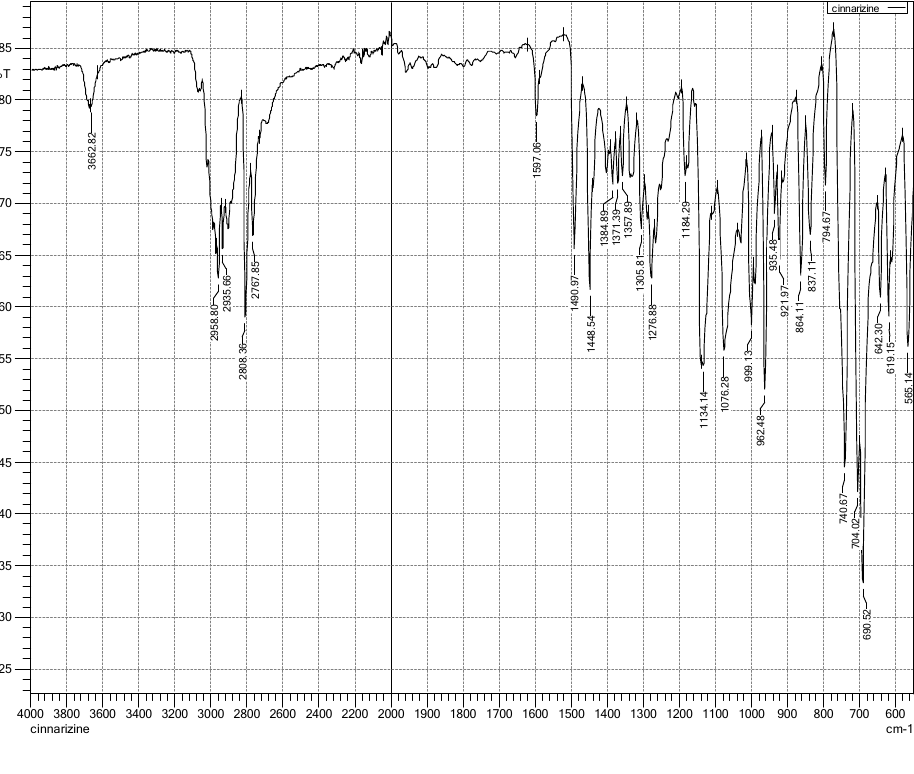
Figure 5. FTIR spectrum of cinnarizine pure drug. Table 5. Principal peaks with assignments of cinnarizine pure drug. Frequency (cm -1 )